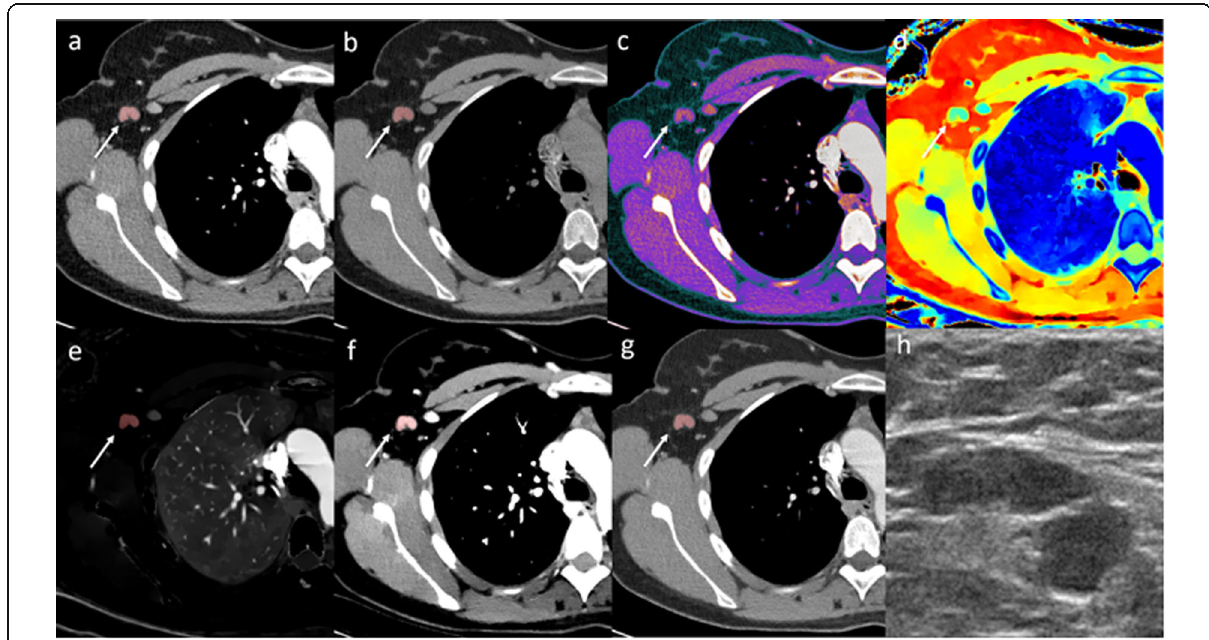
Fig. 1 Arterial phase dual-layer detector spectral CT (DLSCT) examination of a woman with a suspicious lymph node in the right axilla. The lymph node shows high conventional CT HU values ( a ), Δ contrast enhancement ( c ) (conventional CT (HU) ( a ) − virtual non-contrast (HU) ( b )), low Z effective ( d ), high iodine density ( e ), and spectral slope ((mono-energy 40 keV ( f ) minus mono-energy 100 keV ( g ))/60 keV). Based on the cutoff values, DLSCT diagnosed the lymph node as metastatic. Axillary ultrasonography ( h ) described the lymph node as suspicious; however, fine- needle aspiration was negative. Sentinel lymph node biopsy contained malignant tumour cells from invasive ductal